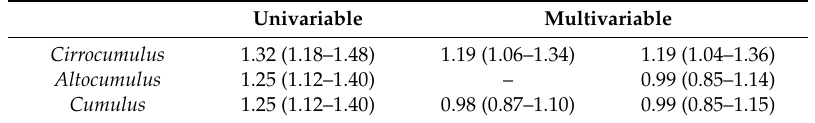
Table 2. Odds ratio per unadjusted standard deviation (OPERA 1 ) for dense area mammographic density measures in predicting screen-detected breast cancer (Nguyen et al. (2018))